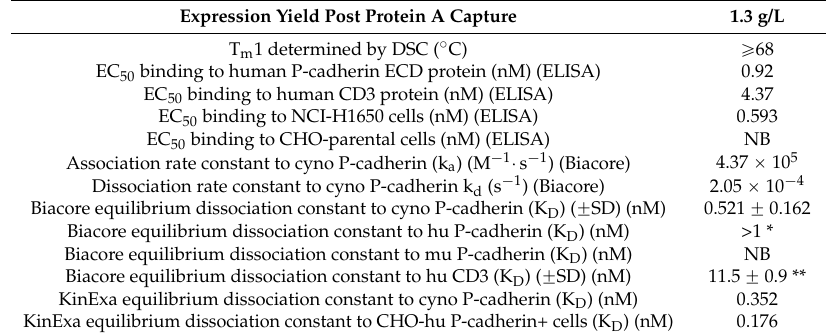
Table 5. Functional and biophysical properties of PF ‐ 06671008. * Due to complexity in the dissociation rates, the K D values could not be accurately determined. This may be caused by heterogeneity of the protein. Binding analyses performed by KinExA and Biacore demonstrated that PF ‐ 06671008 bound to human (cell surface) and cynomolgus monkey P ‐ cadherin (recombinant protein) with similar affinities.